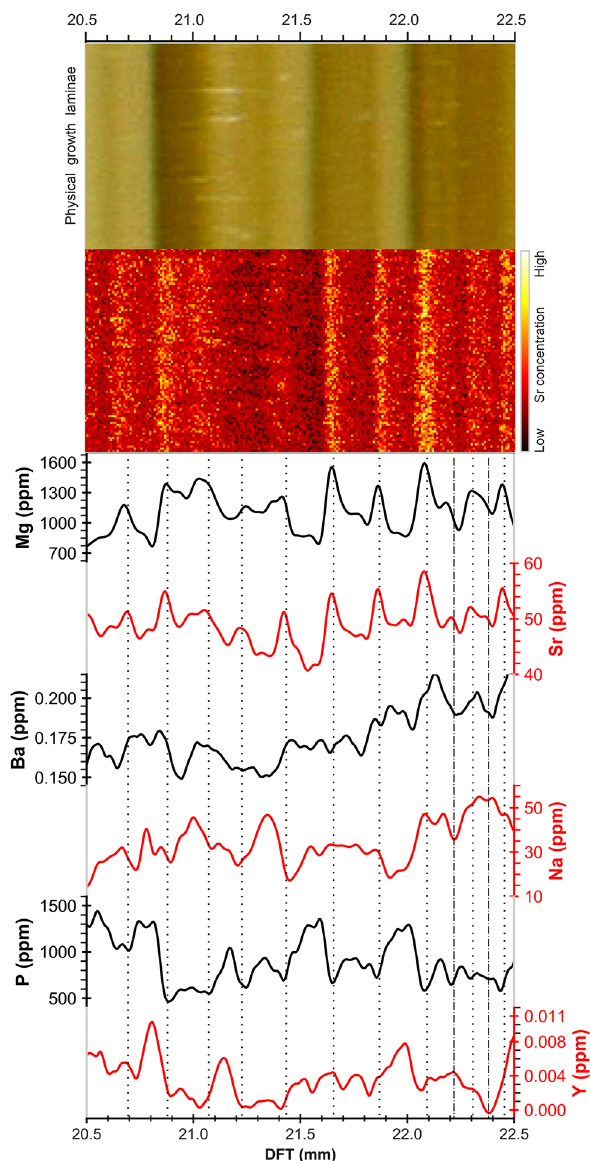
Figure 3. Annually laminated section of Pu17 between 20.5 and 22.5 mm from the top. The dotted vertical lines mark likely annual cycles identified by maximum Sr values on the synchrotron map. These generally correspond to maximum values for Mg, Sr, Ba, Na, U and minima for P and Y on the LA-ICP-MS record. The dashed lines are dubious cycles identified by peaks in only few elements (sub- or double-laminae). Translucent laminae on the physical sample usually correspond to Sr-enriched laminae on the synchrotron